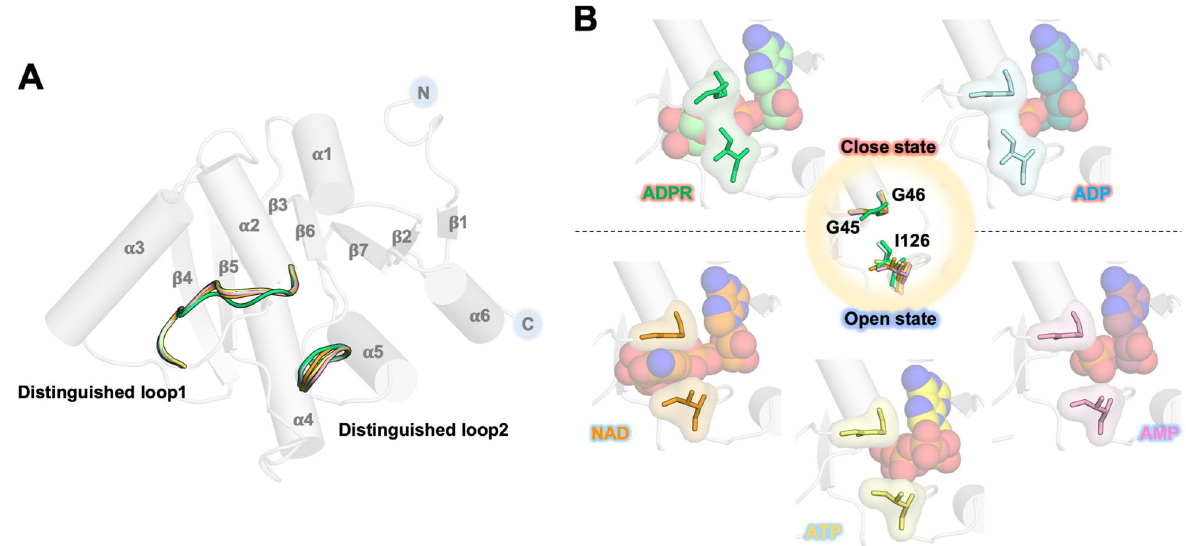
Fig. 2 Two divergences between the fi ve structures of the MERS-CoV macro domain in complex with different NAD metabolites. A Two distinguished loops in protein structures complexed with ADPR, NAD, ATP, ADP, and AMP are represented by ribbon models colored in light green, orange, yellow, cyan, and light pink, respectively. B The closed/open states of the ligand-binding pocket result from the orientation of residues, G45, G46, and I126, located on the two distinguished